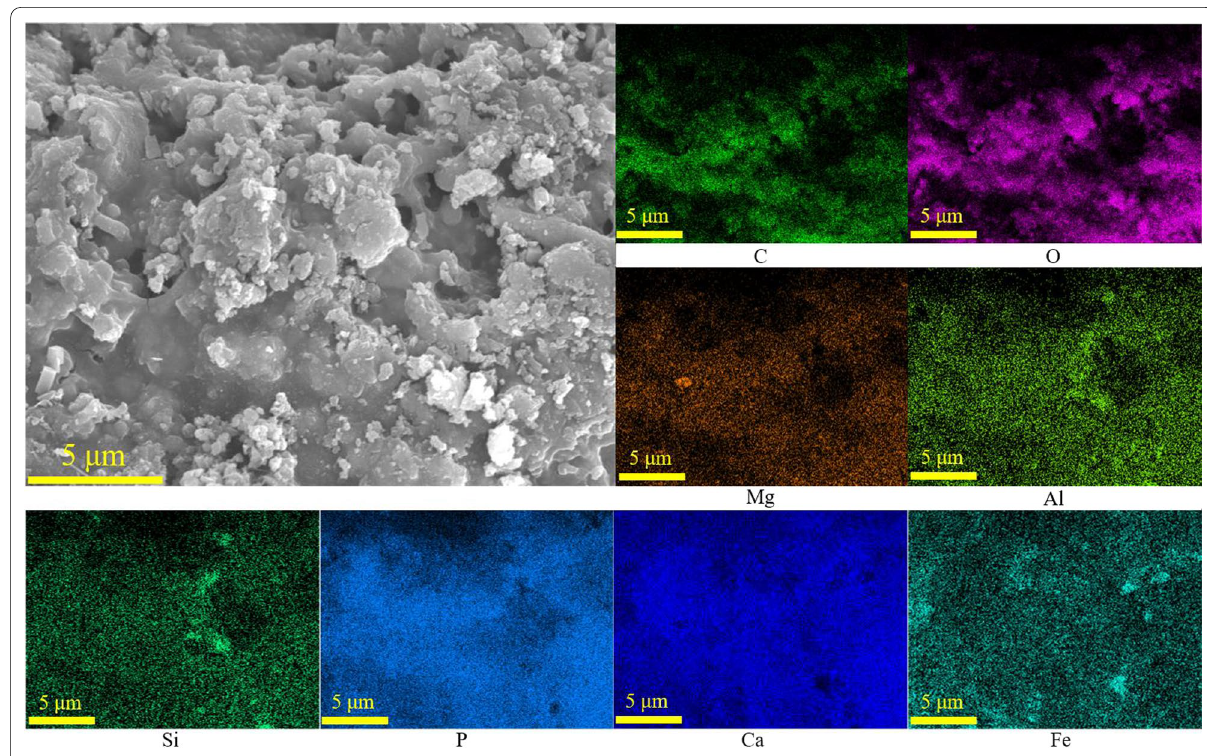
Fig. 2 Surface morphology (magnified by 10,000) and elemental mapping images of the DFW-BC